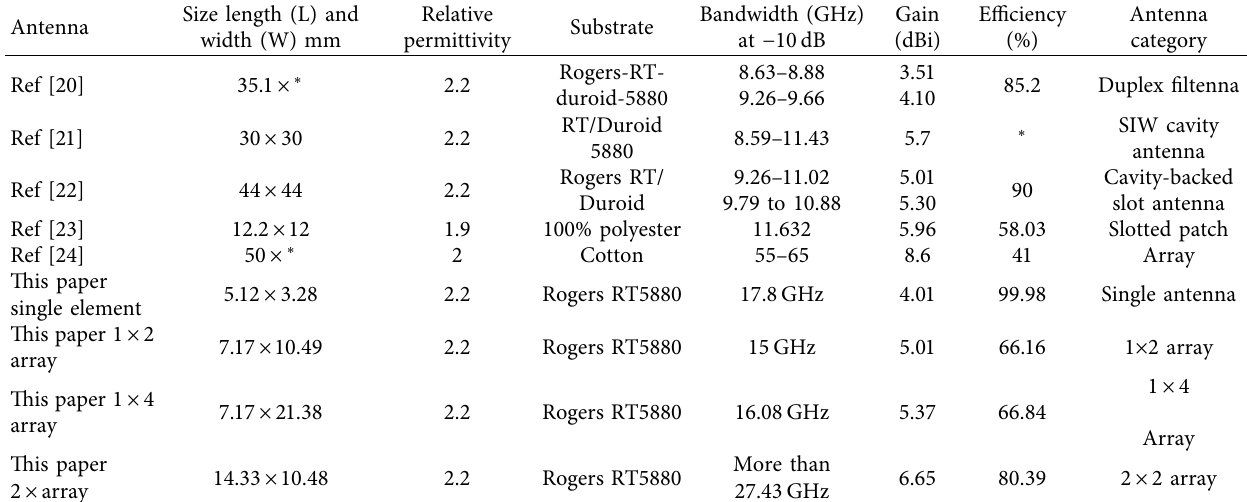
Table 8: A comparison of this paper’s research with that of other